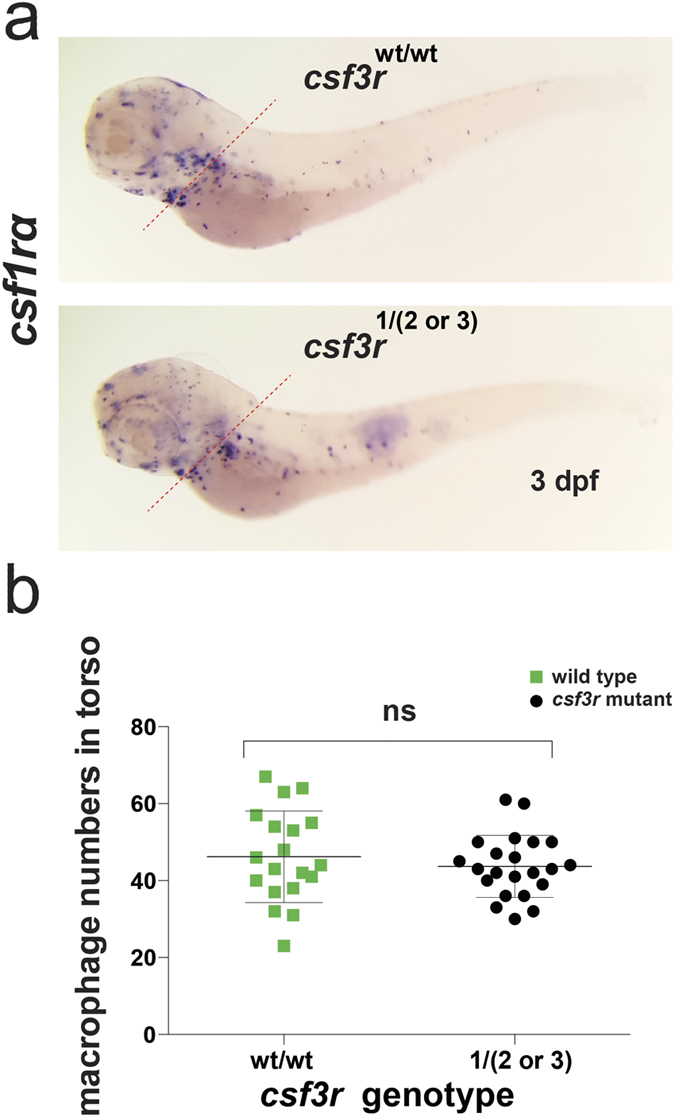
Normal macrophage numbers in csf3r null F2 embryos.(a) Photomicrographs of representative 3 dpf WT and csf3r null embryos stained by whole mount in situ hybridisation (WISH) for the macrophage-specific marker csf1ra/cfms. (b) Quantification of torso-located macrophage numbers in csf1ra/cfms WISH embryos in shows no difference between genotypes (the torso being the region distal to the dotted red line in (a), selected for scoring for its lower density of macrophages and lower incidence of overlapping cells).